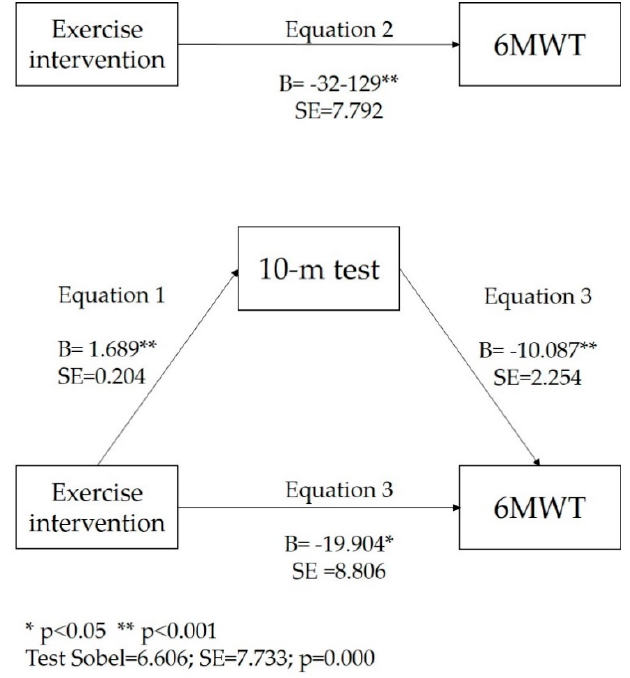
Figure 2. Mediation of exercise intervention and 6MWT by 10-metres test. ** p ˂ 0.001; * ˂ 0.05.